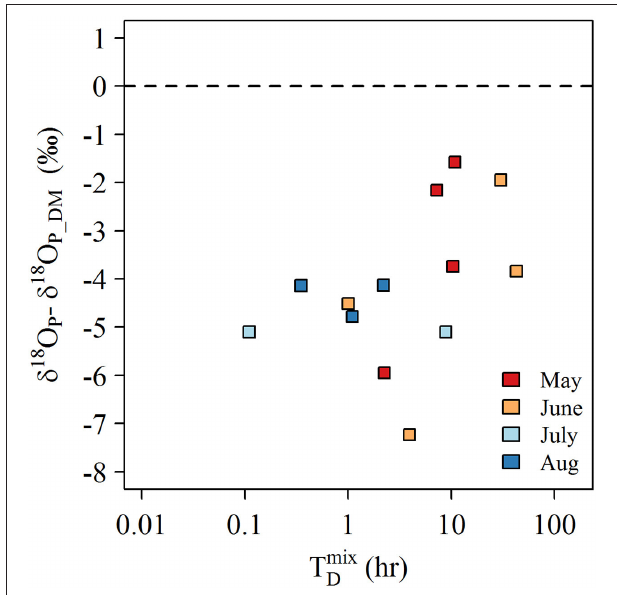
FIGURE 10 | Plot of the offset of δ 18 O P in LB samples from the average experimentally determined δ 18 O P_DM (11.9 ± 1.1 ‰ ) against the estimated time to completely mix the water column ( T mix D ) for samples collected 0.1m above bottom at stationsof 3m